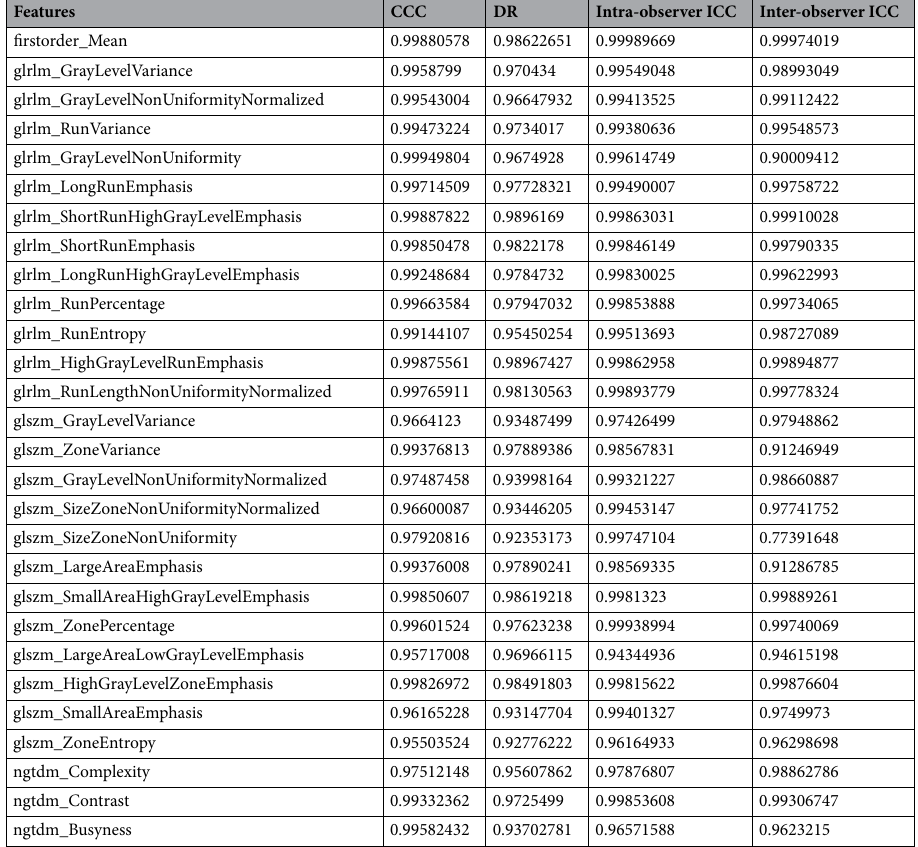
Table 1. T2 map—robust and reproducible features. T2 map acquisition robust and reproducible features as defined by CCC & DR ≥ 0.9 and inter-/intra-ICC ≥ 0.75. CCC, concordance correlation coefficient; DR, dynamic range; firstorder, first-order features; GLCM, gray level co-occurrence matrix; GLDM, gray level difference matrix; GLRLM, gray level run length matrix; GLSZM, gray level size zone matrix; ICC, intraclass correlation coefficient; NGTDM, neighboring gray tone difference matrix. https:// pyrad iomics. readt hedocs. io 19